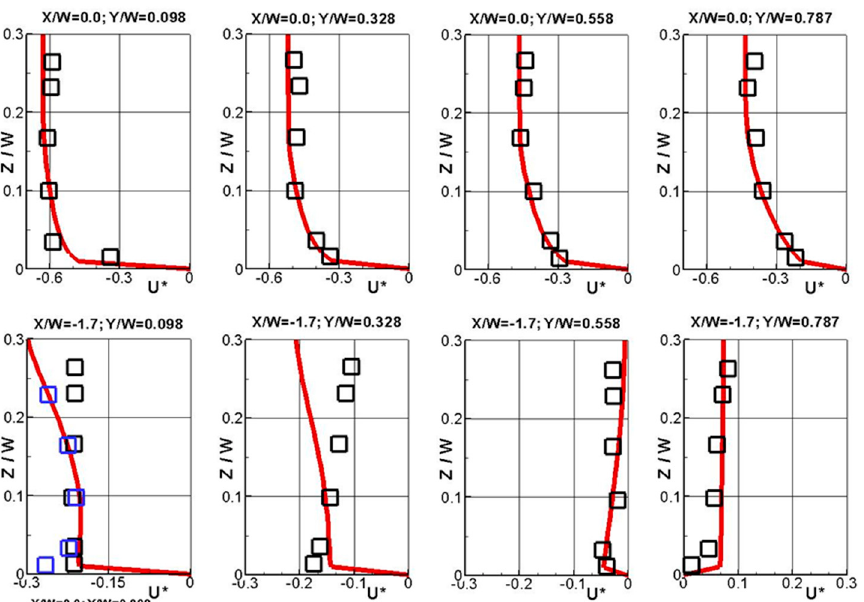
Figure 5. Comparisons of u-velocity vertical profiles in the main channel at measured horizontal (xy) points. black symbols are the measured data from Ramamurthy et al. [3], while blue symbols are according to Qu [55].